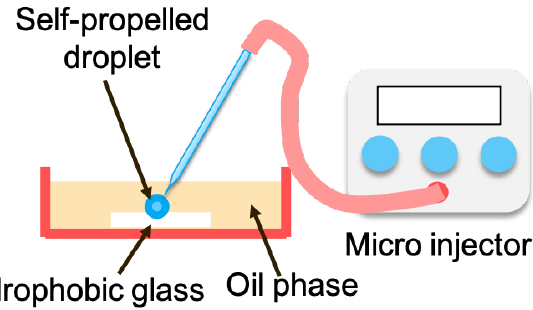
Figure 6. Experimental condition.